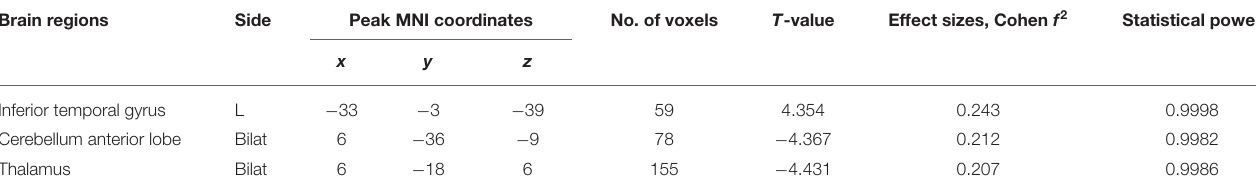
TABLE 2 | Brain regions with significant differences in ALFF values between LPD and control subjects. Brain regions Side Peak MNI coordinates No. of voxels T -value Effect sizes, Cohen f 2 Statistical power